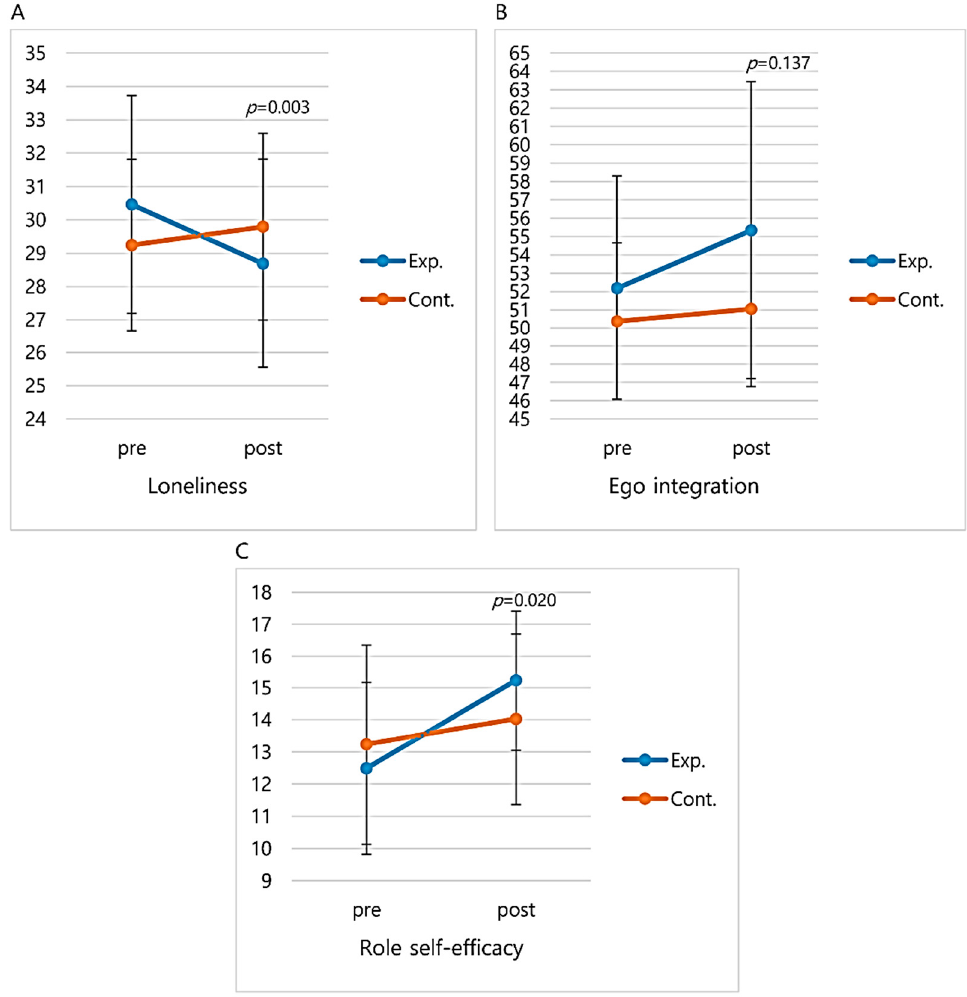
Figure 5. Comparison of loneliness, ego integration, and role self-efficacy before and after the integration healthcare program. ( a ) Change in loneliness mean score. ( b ) Change in ego integration mean score. ( c ) Change in role self-efficacy mean score. Data represent the mean values with standard deviation. Significance level was set to 0.05. Exp. = Experimental group; Cont. = Control group.